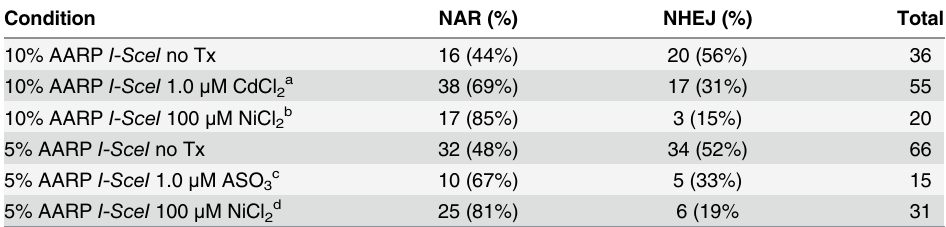
Table 1. Number of recovered